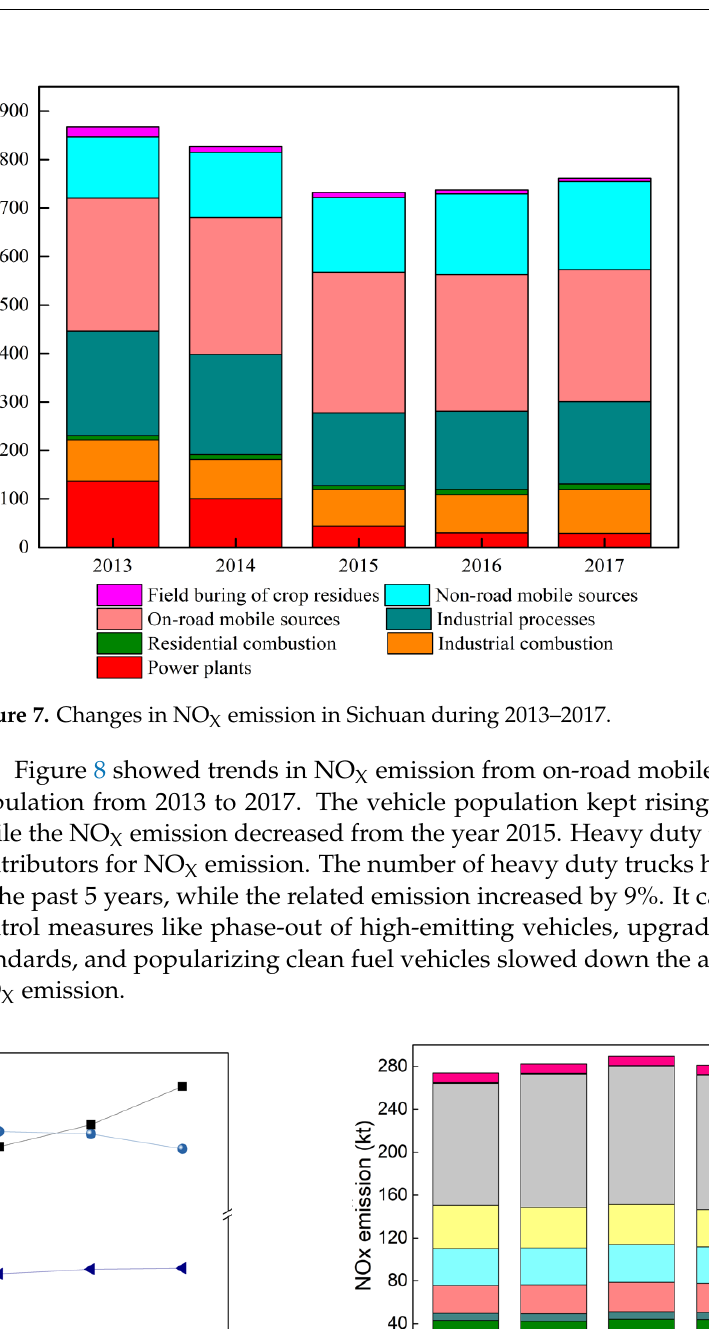
X emission from vehicle